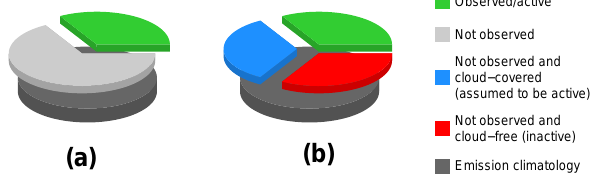
Figure 4. Pie charts illustrating the flaring emission uncertainty as- sessment due to cloud cover for TP15. The entity of the flares within the emission climatology ( E clim ) is given as a closed gray pie in the bottom of (a) and (b) . Panel (a) distinguishes between flares which are detected/active at a certain day (green) and the comple- ment of undetected flares (light gray). In (b) the light gray slice of (a) is separated in a cloud-covered (blue) and cloud-free (red) part by using the cloud mask of VNF flare . Flares that are not detected by VNF flare and covered by clouds are taken as active. Flares that are not detected by VNF flare and are not covered by clouds are taken as